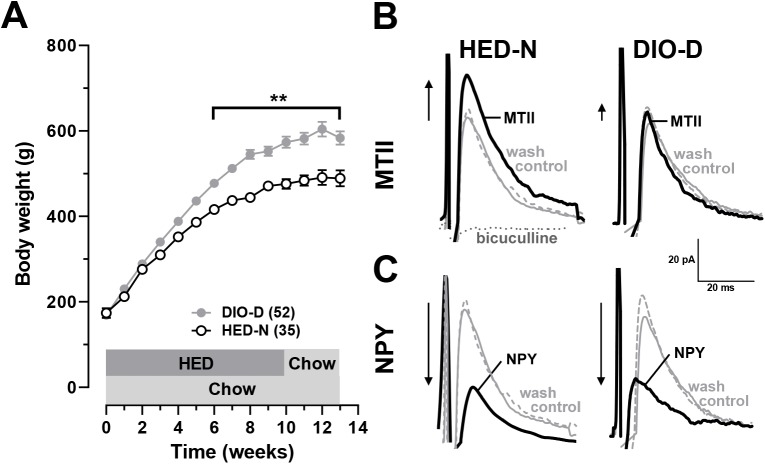
HED-fed, inbred obesity prone (OP-CD) rats have reduced responses to MTII.(A) Weekly mean body weights of OP-CD strain Sprague-Dawley rats fed either HED or chow. When returned to chow, HED-fed rats defended their diet-induced obesity (DIO-D) relative to HED-naïve (HED-N) littermates. (B) Representative IPSC recordings from neurosecretory (NS) mpPVN cells from HED-N (left) and DIO-D (right) rats superimposed in control (solid gray), 100 nM MTII (black) and after washout (dashed gray). IPSCs are abolished by application of 50 μM bicuculline (dashed dark grey, left). Arrows to the left of traces indicate the relative direction and magnitude of MTII-mediated changes. MTII responses were significantly attenuated in PVN NS cells of DIO-D rats relative to HED-N rats. (C) Representative IPSC recordings from HED-N (left) and DIO-D (right) rats superimposed in control (solid gray), 300 nM NPY (black) and wash (dashed gray). Arrows to the left of the traces indicate the relative direction and magnitude of NPY-mediated IPSC changes. There was no significant difference between the effects of NPY in PVN NS cells of DIO-D and HED-N rats. ** p < 0.01.